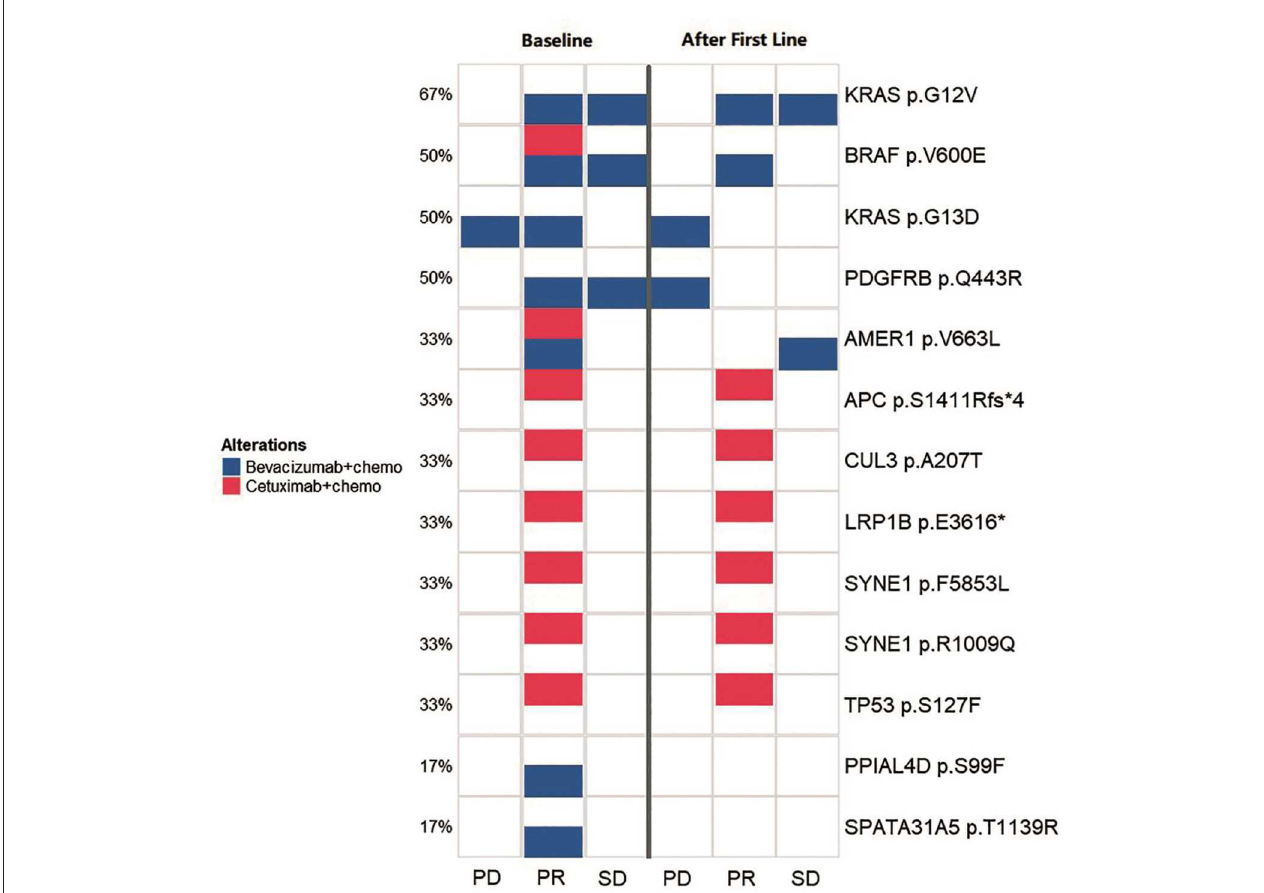
FIGURE 4 | Comparison of the spectrum of key mutations before and after the first-line therapy. The left three lanes (baseline group) and the right three lanes (after first line group) indicate the high-frequency mutational status for baseline (before the first-line therapy) and after the first-line therapy. Annotations to the right of the panel show the exact mutations and the percentage to the left of the panel shows the frequency for a certain mutation. The three lanes in both group illustrates the mutational status for PD, PR, and SD groups, respectively. Blue squares indicates cases with bevacizumab/chemotherapy that carried corresponding labeled mutations and red squares indicates cases with cetuximab/chemotherapy that carried corresponding labeled